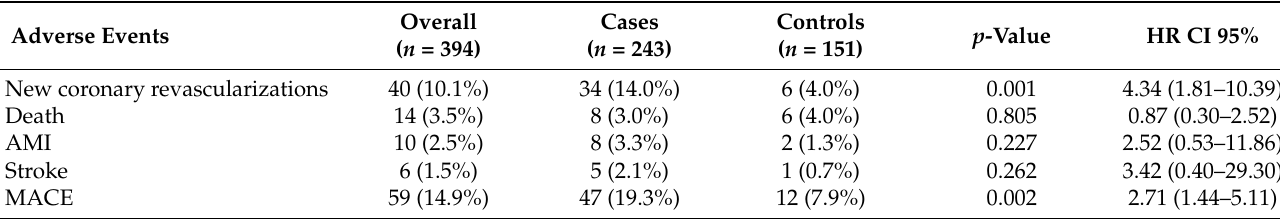
Table 2. Adverse events in the study